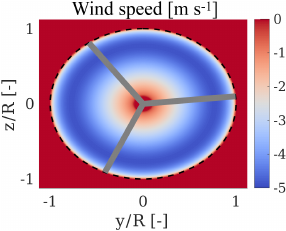
Figure 5. The initial wake deficit directly evaluated at the rotor (at 0m downstream). The mean hub-height wind speed (8ms − 1 ) was removed for simplicity. No yaw misalignment is